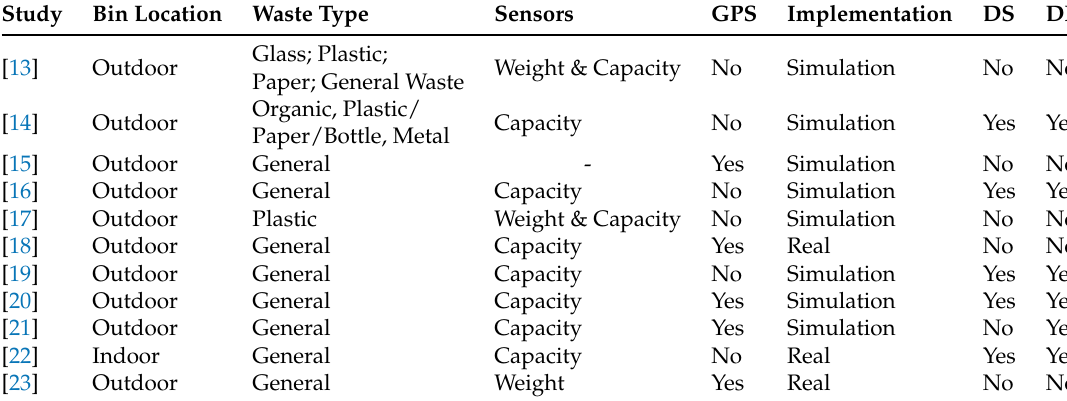
Table 2. A comprehensive analysis based on the prior art on SWC (Dynamic Scheduling DS, Dynamic Routing